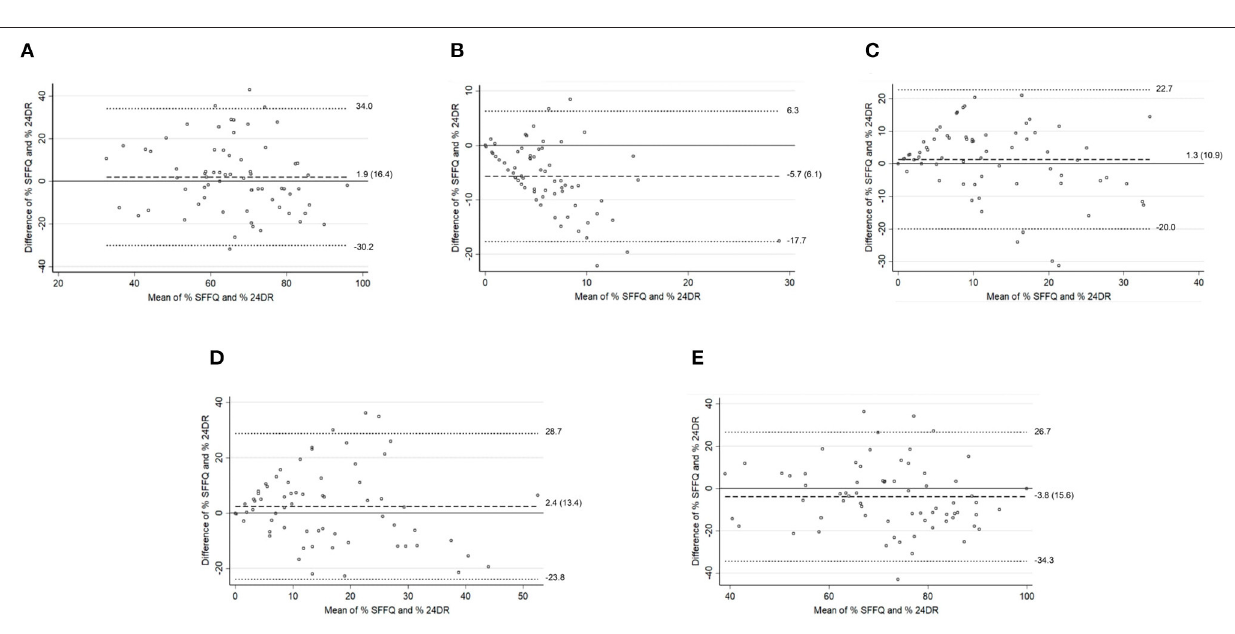
intakes may give more accurate information than methods not based on memory (the dietary record) (37,